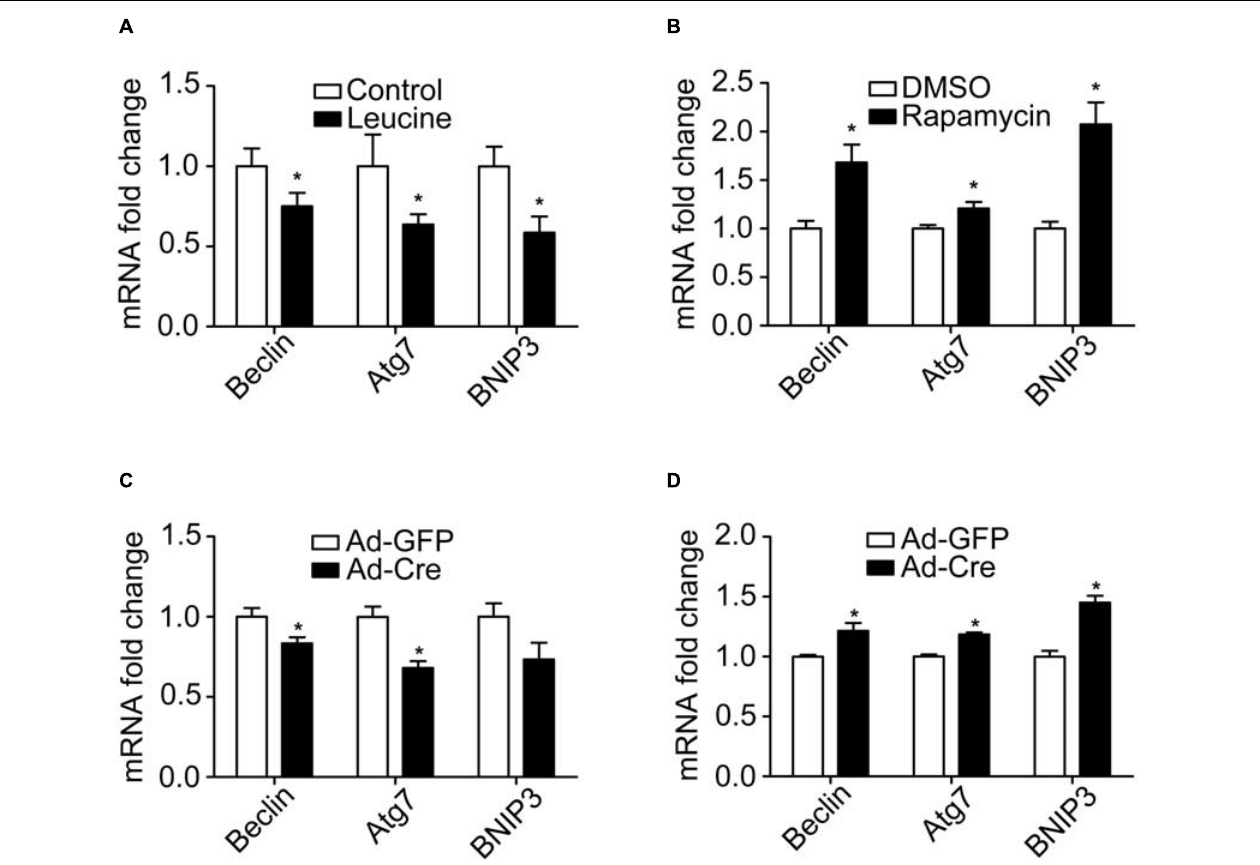
FIGURE 5 | mTOR signaling pathways change mitochondrial autophagy of brown adipocytes. (A,B) Primary brown adipocytes were isolated from neonatal C57BL/6J mice and cultured for differentiation. Total RNAs were extracted after 6 days of differentiation. Real-time PCR was performed to evaluate the expression of mitochondrial autophagy marker genes with β -actin as a loading control and results expressed as means ± SD. *Denotes P < 0.05 relative to control. (C) TSC1 loxp / loxp brown adipocytes were treated with Cre adenoviruses for 48 h and controls with GFP adenoviruses. RNAs were extracted as described in the methods section. Real-time PCR was performed to evaluate the expression of genes related to mitochondrial autophagy. Levels of mRNA expression were normalized to β -actin and expressed as means ± SD. (D) mTOR loxp / loxp brown adipocytes were treated with Cre adenoviruses for 48 h and controls with GFP adenoviruses. RNAs were extracted as described in the methods section. Real-time PCR was performed to evaluate the expression of genes related to mitochondrial dynamics. Levels of mRNA expression were normalized to β -actin and expressed as means ± SD. * P < 0.05 vs.